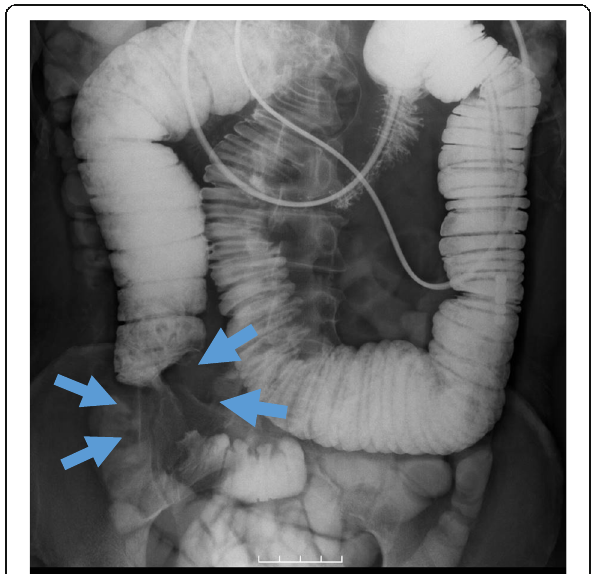
Fig. 2 Small bowel series via the ileus tube shows severe obstruction in the jejunum with upstream dilatation